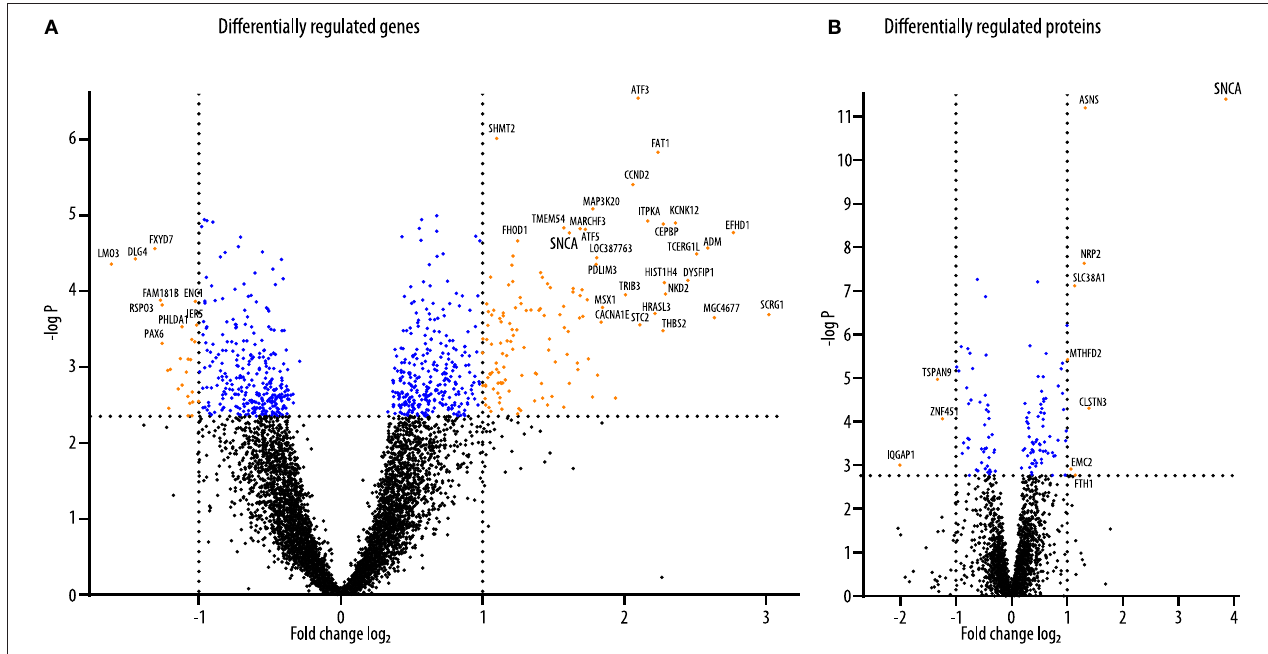
FIGURE 2 | Volcano plots of differentially regulated genes and proteins. (A) The volcano plot of transcripts of genes that were differentially regulated between α Syn-overexpressing and GFP-expressing LUHMES cells. Blue dots indicate all transcripts that were above the threshold for statistical significance after correction for multiple testings (adjusted p -value < 0.05). Orange dots indicate those of the statistically significant regulated transcripts were regulated more than 2-fold. Of these, 27 were downregulated (orange dots on the left), and 130 were upregulated (orange dots on the right). (B) The volcano plot of proteins that were differentially regulated between α Syn-overexpressing and GFP-expressing LUHMES cells. Blue dots indicate all proteins that were above the threshold for statistical significance after correction for multiple testings (adjusted p -value < 0.05). Orange dots indicate those of the statistically significant regulated proteins that were regulated more than 2-fold. Of these, three were downregulated (orange dots on the left), and eight were upregulated (orange dots on the right).